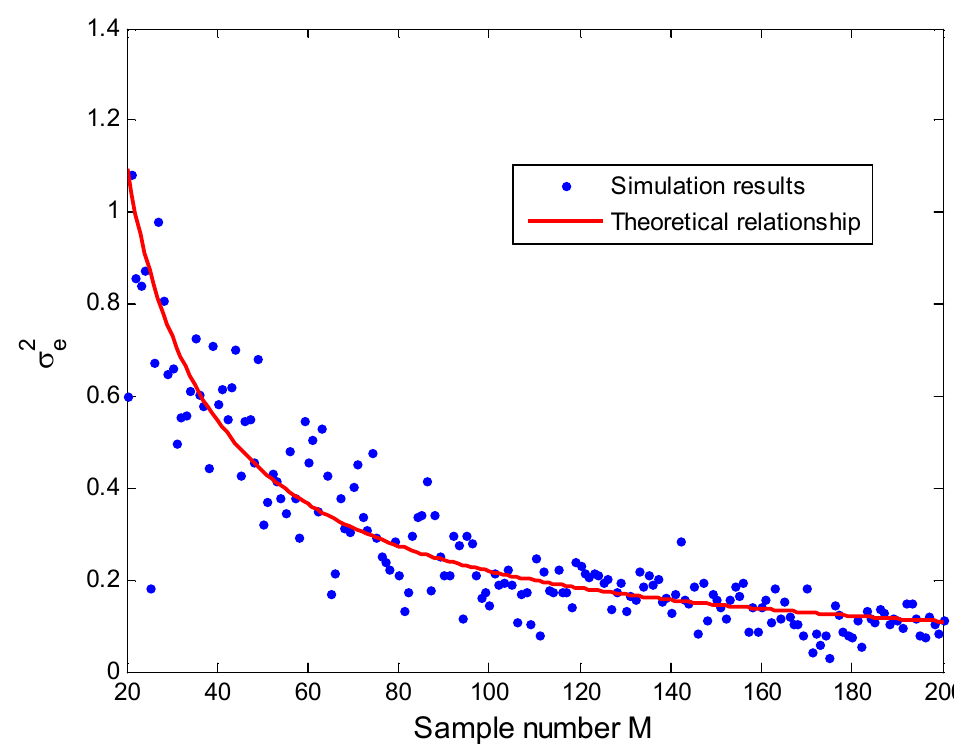
15 of 23 Figure 9. Relationship between 2 e  and M for 5 k d 